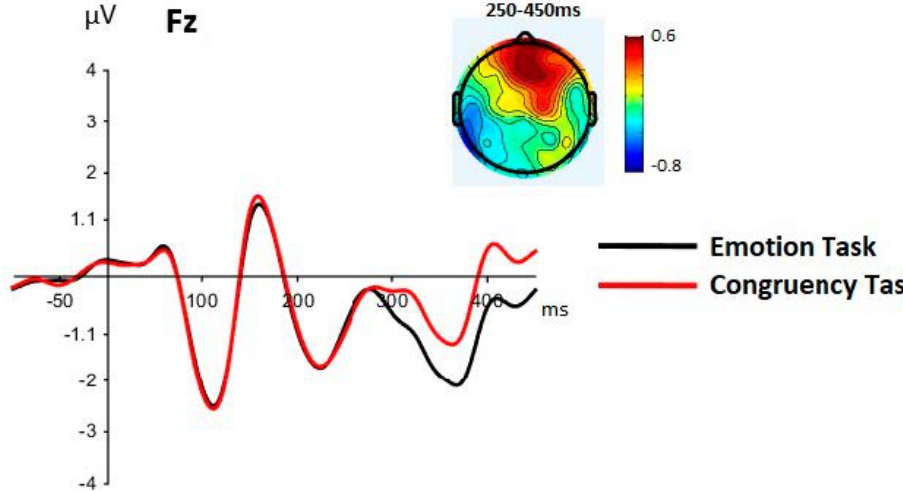
Figure 5. Group grand averaged waveforms for each task (averaged across emotion and congruency). The effect of task was mainly seen at frontal sites (exemplified by Fz here), with larger amplitudes for the congruency task compared to the emotion task, between 250 and 450 ms. The topographic map shows the task effect (congruent minus emotion task) between 250 and 450 ms. Table 3. Statistical results obtained for the analyses on mean amplitudes calculated over two time windows at two clusters (frontal and centro-parietal clusters).